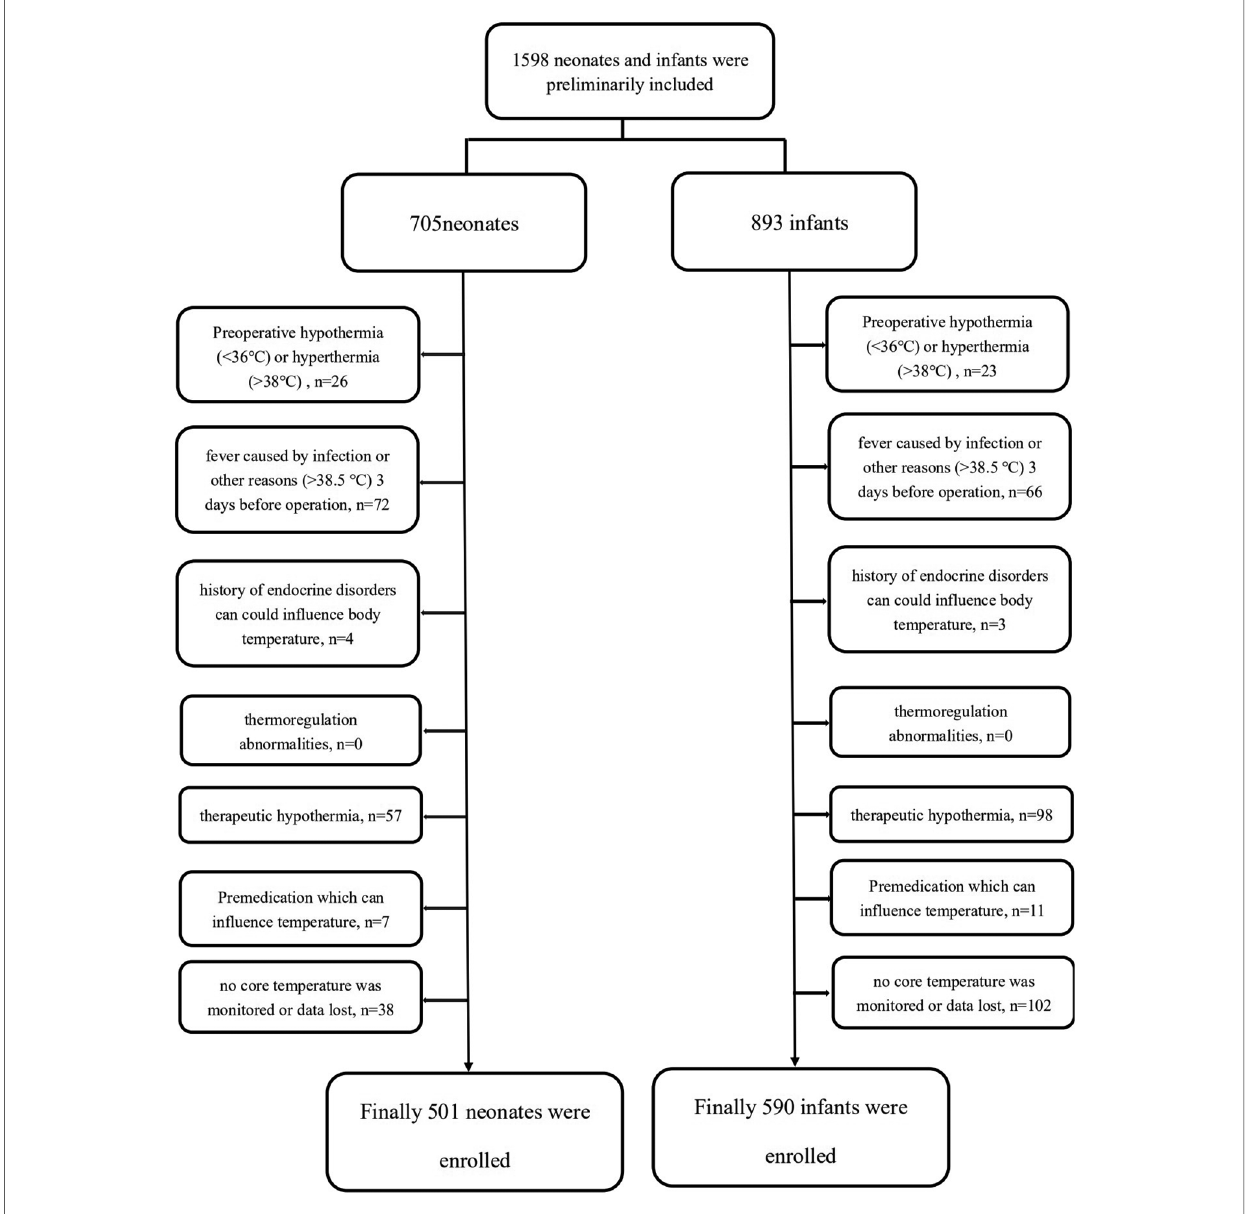
FIGURE 1 Flow chart of inclusion and exclusion criteria of neonates and